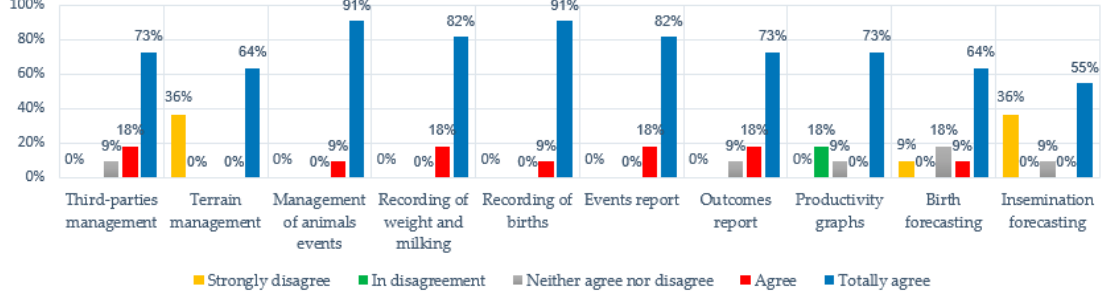
Figure 12. Results of the evaluation of functionalities